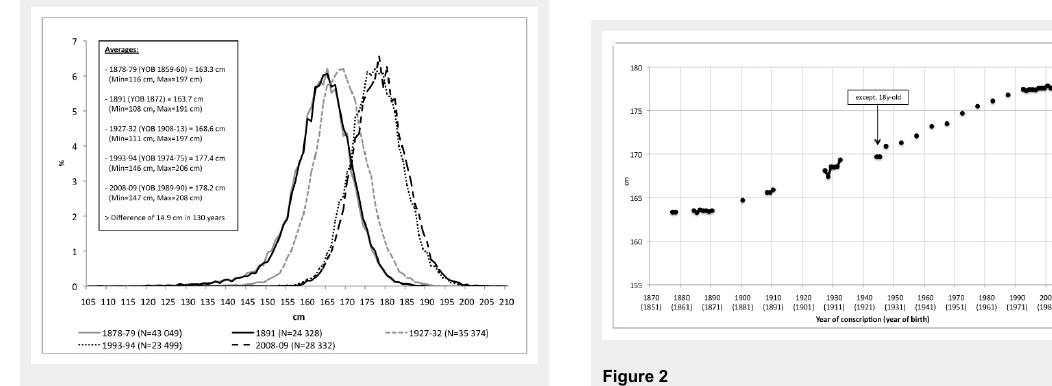
Shifting of the height distribution of 19-year-old Swiss conscripts from 1878–79 to 2008–09 (complete conscription years).